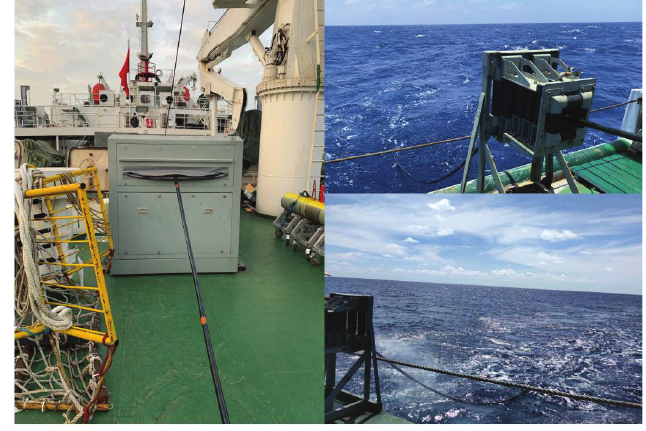
Figure 24. Profile display of equipment in the marine environment.